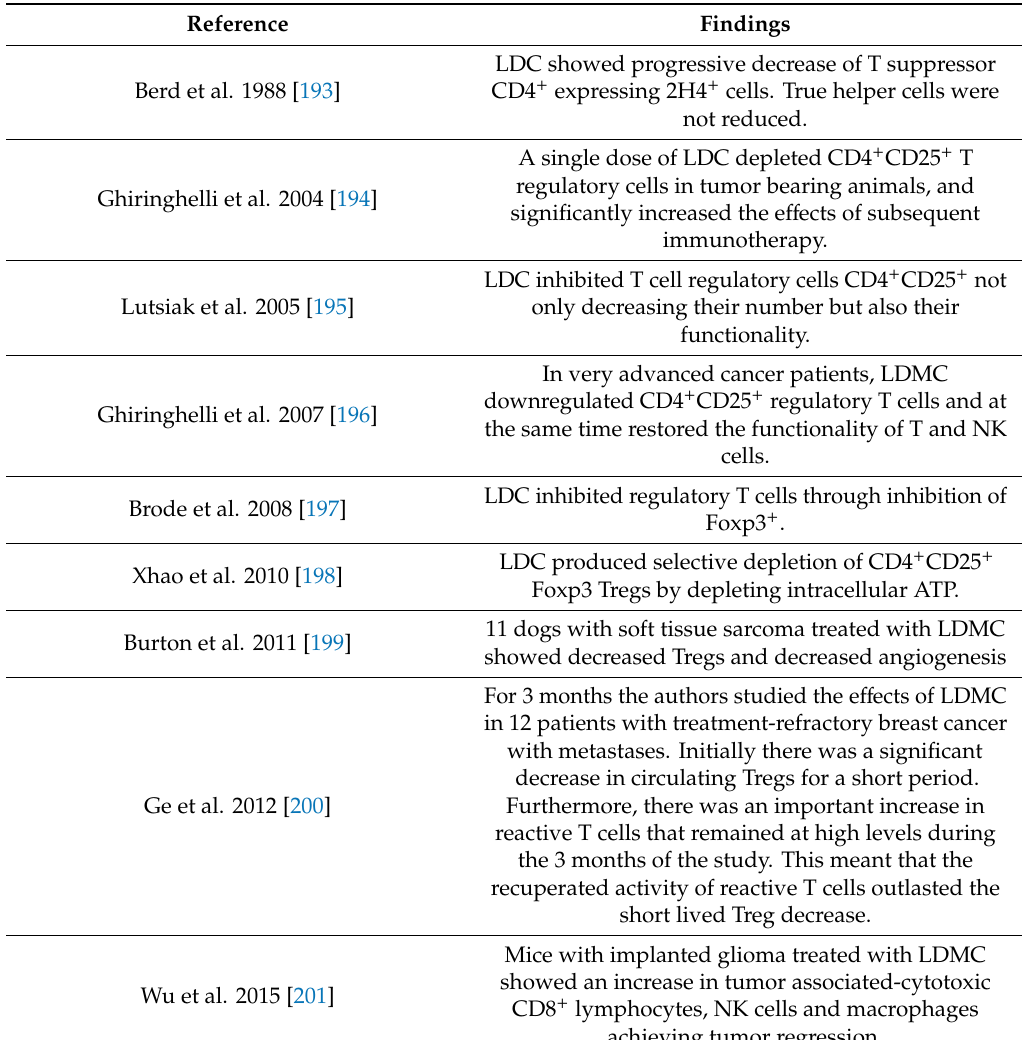
Immune e ff ects of low dose cyclophosphamide (LDC) and low dose metronomic cyclophosphamide